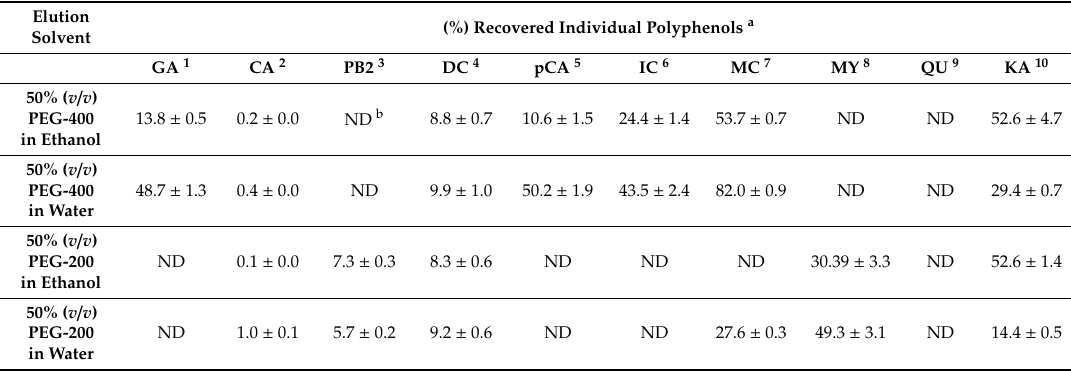
Table 2. Relative peak areas of eluted polyphenols with various solvent systems as determined by high-performance liquid chromatography